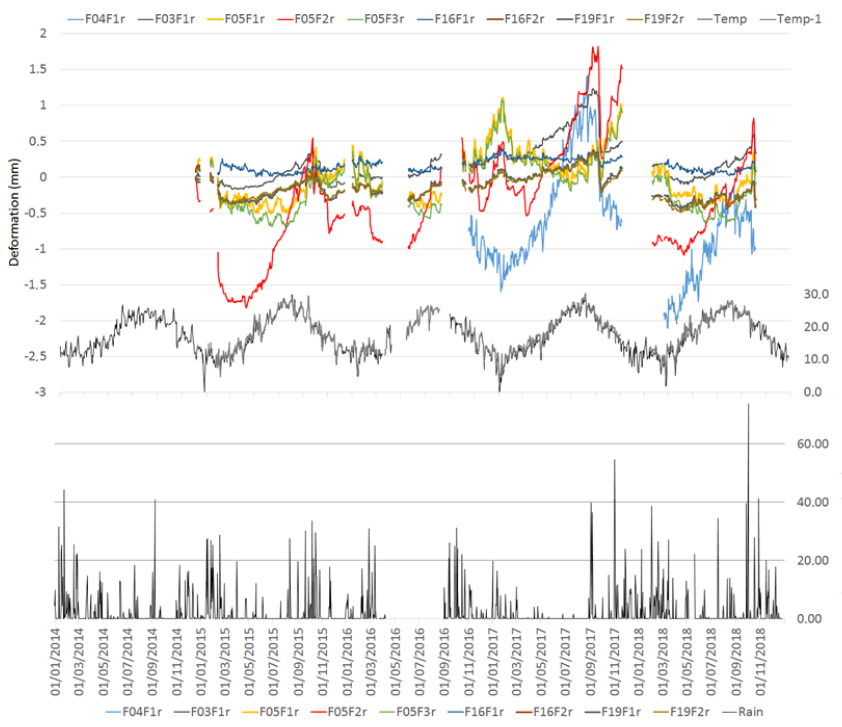
Figure 21. Comparison between crackmeter measurements, rain amount and daily temperature data time series.